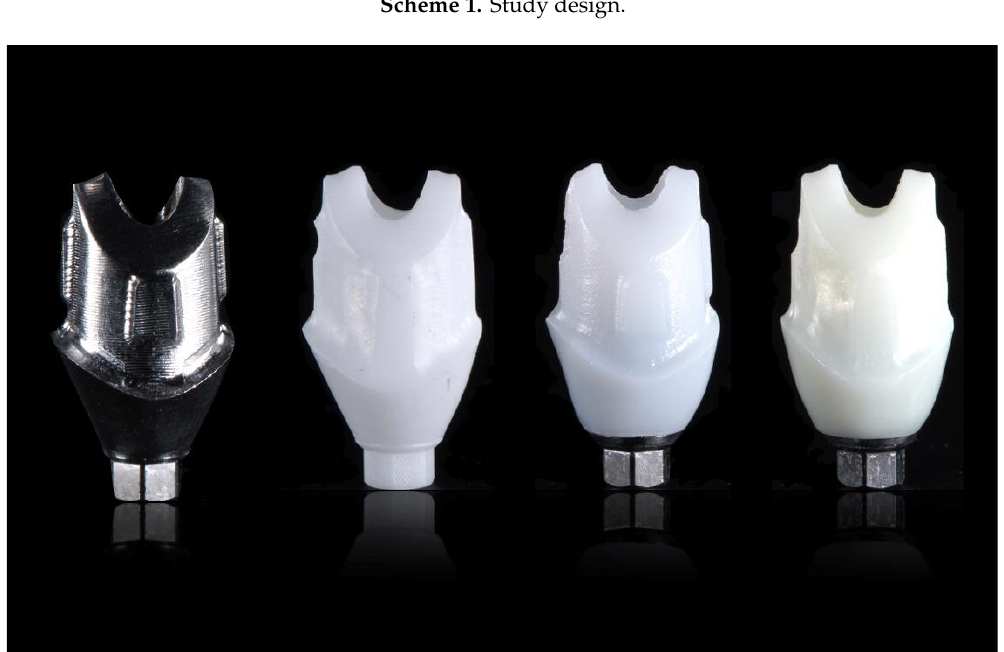
Figure 1. Examples of examined computer-aided design/computer-aided manufacturing (CAD/CAM) abutment specimens from left to right: titanium monotype abutment (CADAbut F, CAD Titanium), zirconia monotype abutment (CADAbut F, BeCe CAD Zirconia XH), zirconia hybrid abutment (CADAbut D, Zirconia LT CAD on Ti-Base), lithium disilicate hybrid abutment (CADAbut D, IPS e.max CAD LT on Ti-Base).